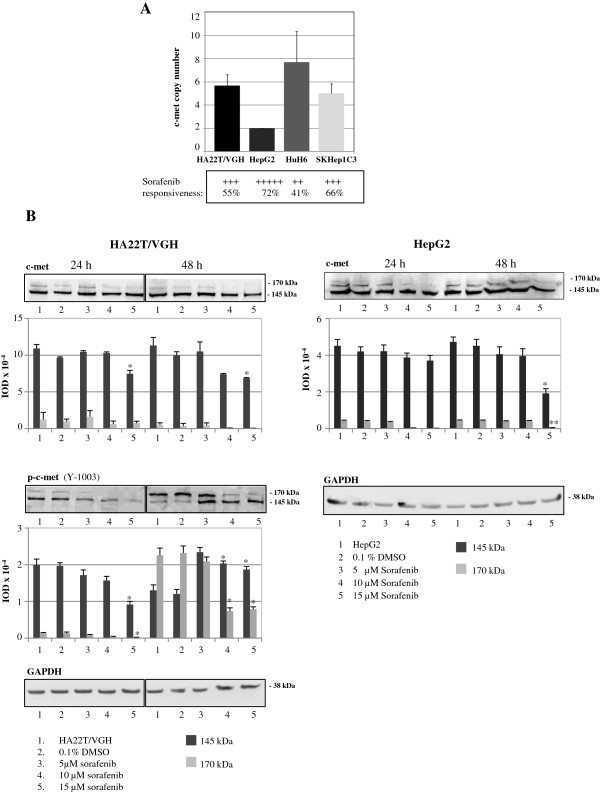
Effects of sorafenib on c-met protein expression levels. (A) c-met copy number analysis in the 4 HCC cell lines considered and comparison with the highest percentage of inhibition of proliferation observed after sorafenib treatments. (B) Western blot and densitometric analysis of c-met, p-c-met (Y1003) and GAPDH in the HA22T/VGH and HepG2 cells treated with sorafenib *p < 0.05; **p < 0.01 versus HA22T/VGH or HepG2 in a t-Test analysis for unpaired comparison.